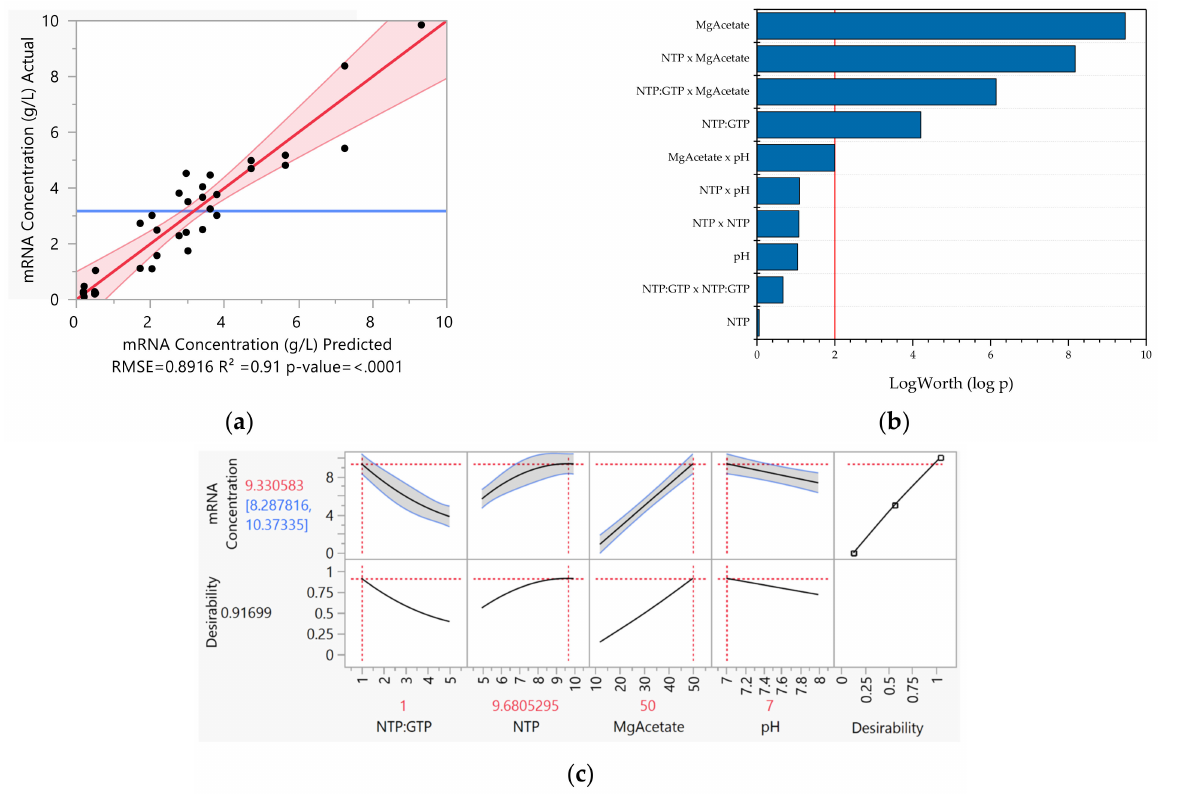
Figure 14. Statistical evaluation of DoE using OLS with stepwise reduced p -value. ( a ) Actual-vs- predicted plot with marked confidence interval (red shadow); ( b ) Effect summary with the marked threshold for significance (logWorth of 2.0, red line); and ( c ) Prediction of optimal operating point.